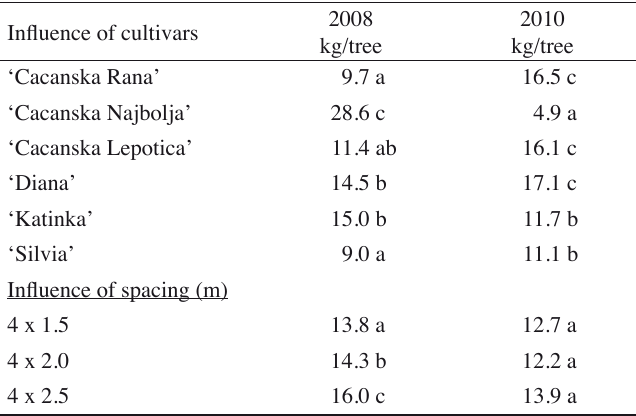
Table 10 - Influence of cultivars and spacing on yield (kg/tree) in the fourth and sixth years from planting (2008 and 2010 z )